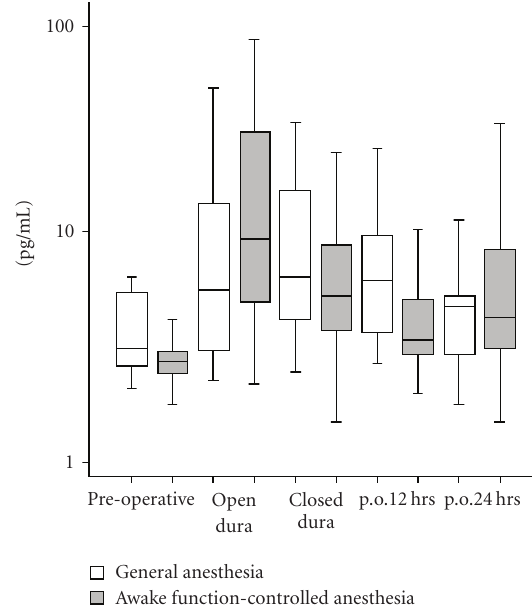
Figure 3: Box plots of plasma IL-10 levels . IL-10 levels do not significantly change throughout time for both experimental groups. No significant di ff erence in plasma IL-10 levels is found between